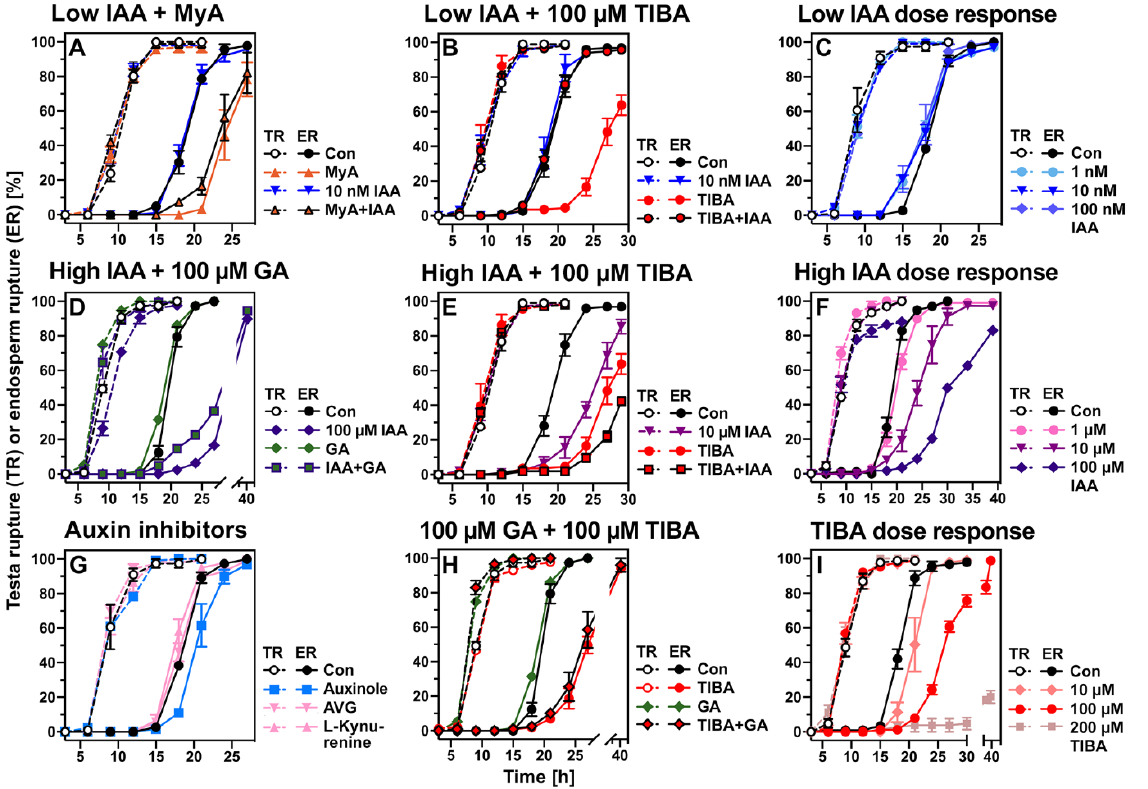
Figure 7. The effects of indole-3-actic acid (IAA), the auxin transport inhibitor TIBA, and other auxin-related inhibitors on Lepidium sativum seed germination and its inhibition by myrigalone A (MyA). ( A ) The effect of adding a low IAA concentration on the kinetics of testa rupture (TR) and subsequent endosperm rupture (ER) without (Con, control) or with 0.5 mM MyA added. Note that combined treatment with a low IAA concentration partly reverts the MyA-mediated delay of ER. ( B ) The effect of adding a low IAA concentration on the kinetics of TR and ER without (Con) or with 100 µ M TIBA (2,3,5-triiodobenzoic acid) added. Note that combined treatment with a low IAA concentration fully reverts the TIBA-mediated delay of ER. ( C ) IAA dose-response of cress seed germination for the low concentration range. ( D ) The effects of IAA and gibberellin (100 µ M GA 4+7 ) on germination. ( E ) The effect of adding a high IAA concentration on the kinetics of TR and ER without (Con) or with 100 µ M TIBA added. Note that combined treatment with a high IAA and TIBA resulted in additive ER inhibition. ( F ) IAA dose-response of cress seed germination for the high concentration range. ( G ) The effect of the TIR1 auxin receptor antagonist auxinole (100 µ M) and of the auxin biosynthesis inhibitors (100 µ M) aminoethoxy-vinylglycine (AVG) and L-kynurenine on cress seed germination. ( H ) The effects of TIBA and gibberellin (100 µ M GA 4+7 ) on germination. ( I ) TIBA dose-response of cress seed germination. Note that TIBA inhibits ER in a dose-dependent manner without affecting TR. Seeds were incubated at 20 ◦ C in continuous white light, TR and ER scored over time, mean values ± SEM for 3 replicates each with ca. 30 seeds are